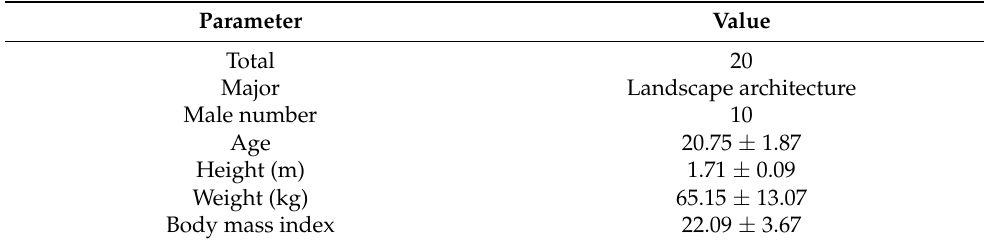
Table 2. Information about study